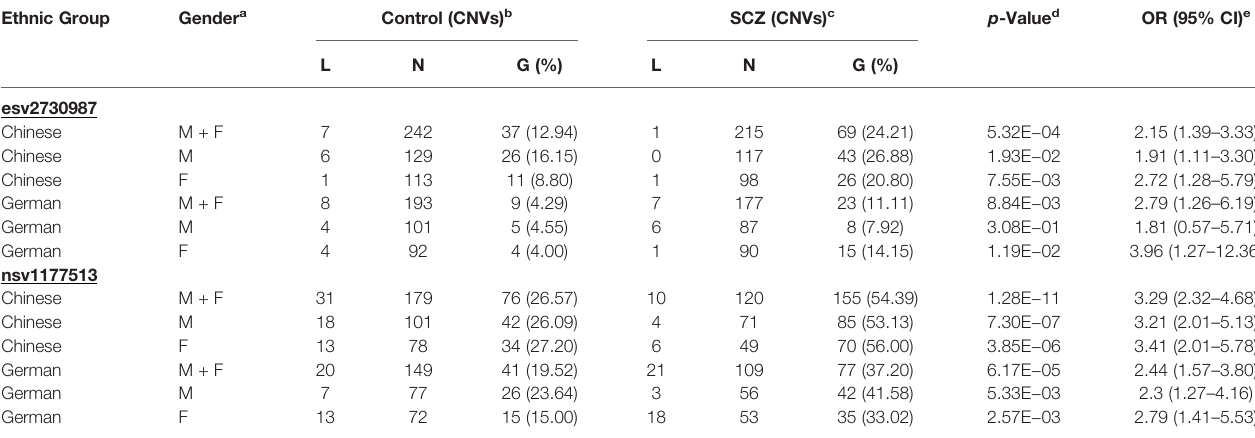
TABLE 2 | Copy number variations in schizophrenia patients from two ethnic groups. Ethnic Group Gender a Control (CNVs) b SCZ (CNVs) c